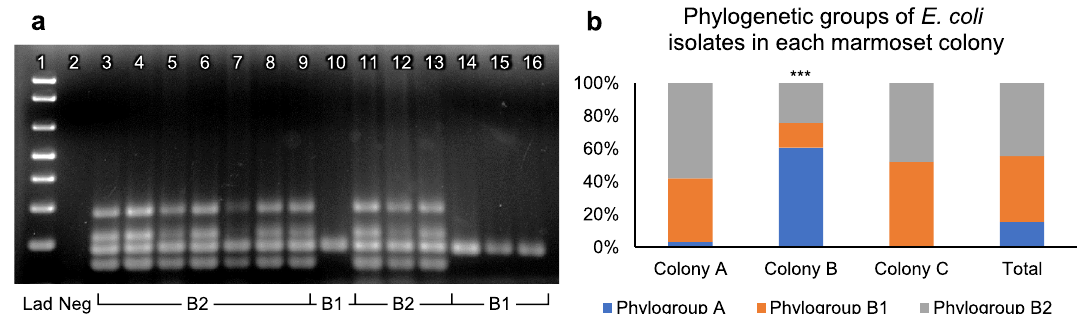
Figure 1. Phylogenetic analysis of E. coli isolates from marmosets. ( a ) Sets of primers for svg , chuA, yjaA , uidA , and TspE4.C2 genes were used in multiplex PCR assays to determine the phylogroup of each isolate. The phylogenetic groups were determined according to the PCR gel pattern, with the presence of 3 or more bands indicating membership in phylogroup B2. Phylogroup multiplex PCR gel: lane 1,1-kb ladder; lane 2, negative control; lane 3, phylogroup B2 positive control (NC101); lanes 4–16, E. coli isolates from marmosets (lanes 3–9 and 11–13, phylogroup B2; lanes 10 and 14–16, phylogroup B1). ( b ) Distribution of phylogenetic groups of E. coli isolated from marmosets according to colony. Colony B had a significantly different distribution than either of the other two colonies. *** p < 0.001, Fisher’s Exact Test. Unedited images of gels are shown in Supplementary Figure S6.